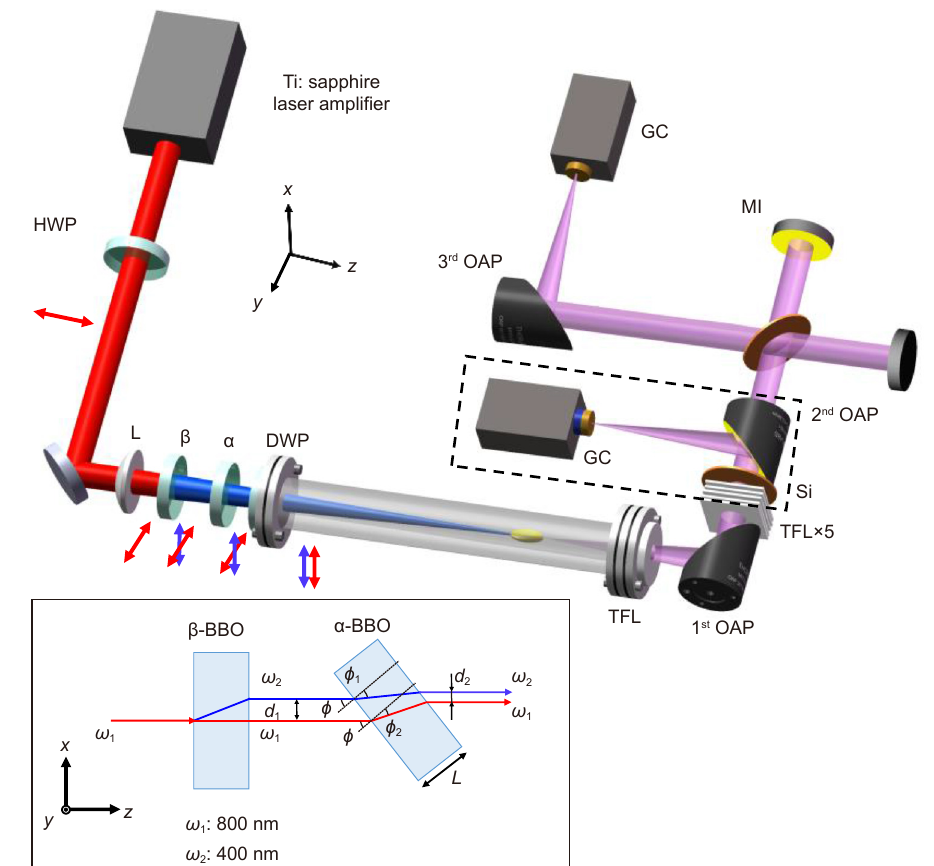
Fig. 1 | Experimental setup for high-energy THz pulse generation by filamentation in gases. The optical elements in the dashed frame need to be removed when measuring the THz autocorrelation curve. HWP: half-wave plate; L: lens; β: β-BBO; α: α-BBO; DWP: dual-wavelength plate; TFL: Teflon; OAP: 90° off-axis parabolic mirror; Si: silicon wafer; GC: Golay cell. Inset: tilting of α-BBO can further realize the precise spatial over- lap of two beams.